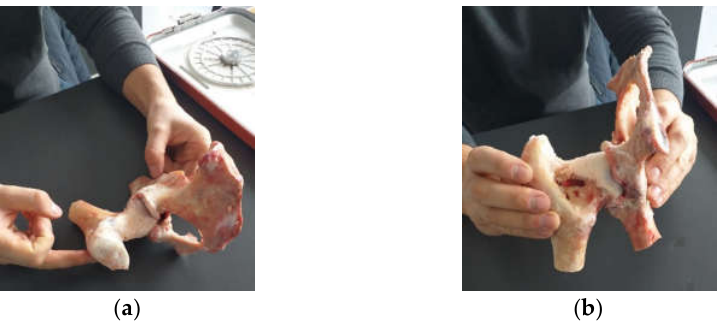
Figure 1. Portion of femur ( a ) and pelvic bone ( b ) taken from an animal (cow).